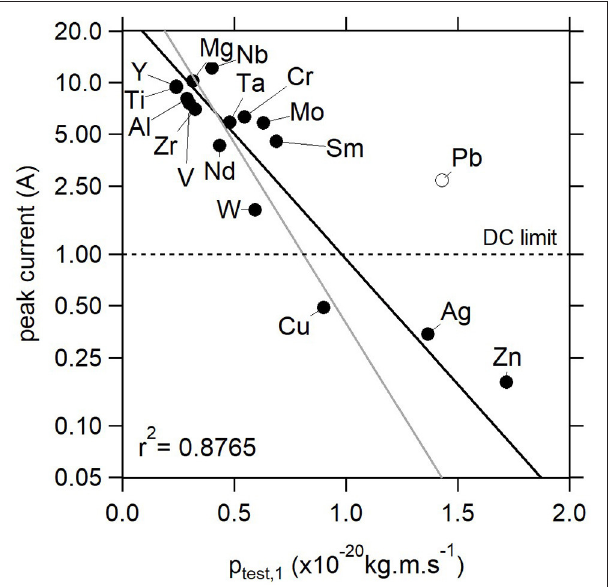
FIGURE 5 | The ratio between the average current measured in the plateau, and in the peak, normalized with the electron yield defines the test parameter 2 (see also Equation 4). This parameter shows a linear correlation with the ionization rate. The latter is calculated according the Deutsch-Mark formalism. The linear fit (see black line), and the presented correlation coefficient are calculated without the data for Mg (open marker). The gray line is the linear fit excluding the datapoints for Ag, Cu, Mg, and